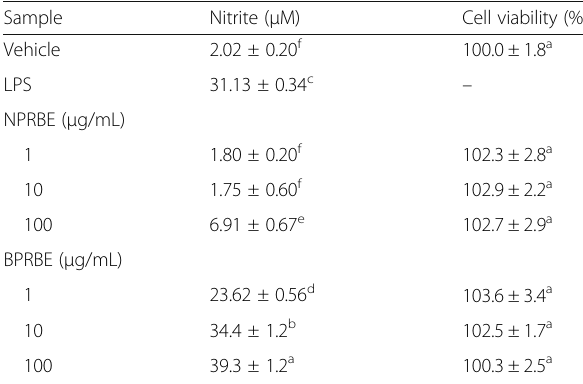
Table 2 Effects of NPRBE and BPRBE on macrophage activation and survival